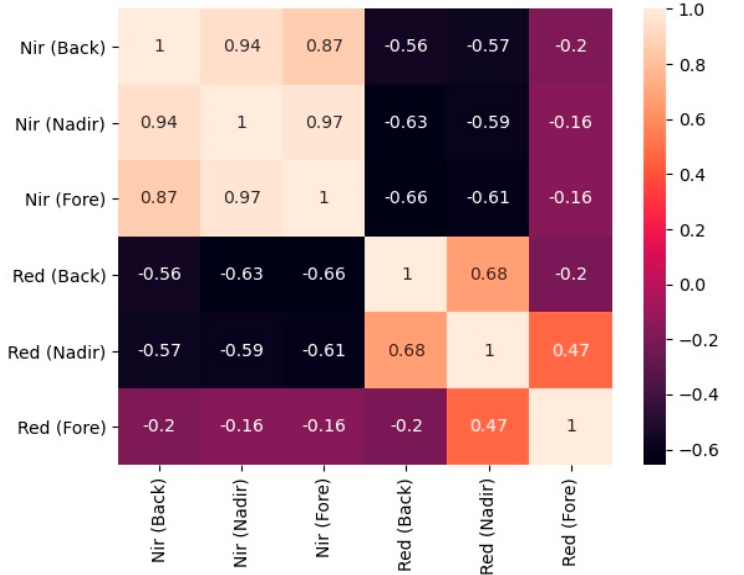
Figure 6. Correlation matrix of the reflectances measured at different angular configurations in the principle plane.